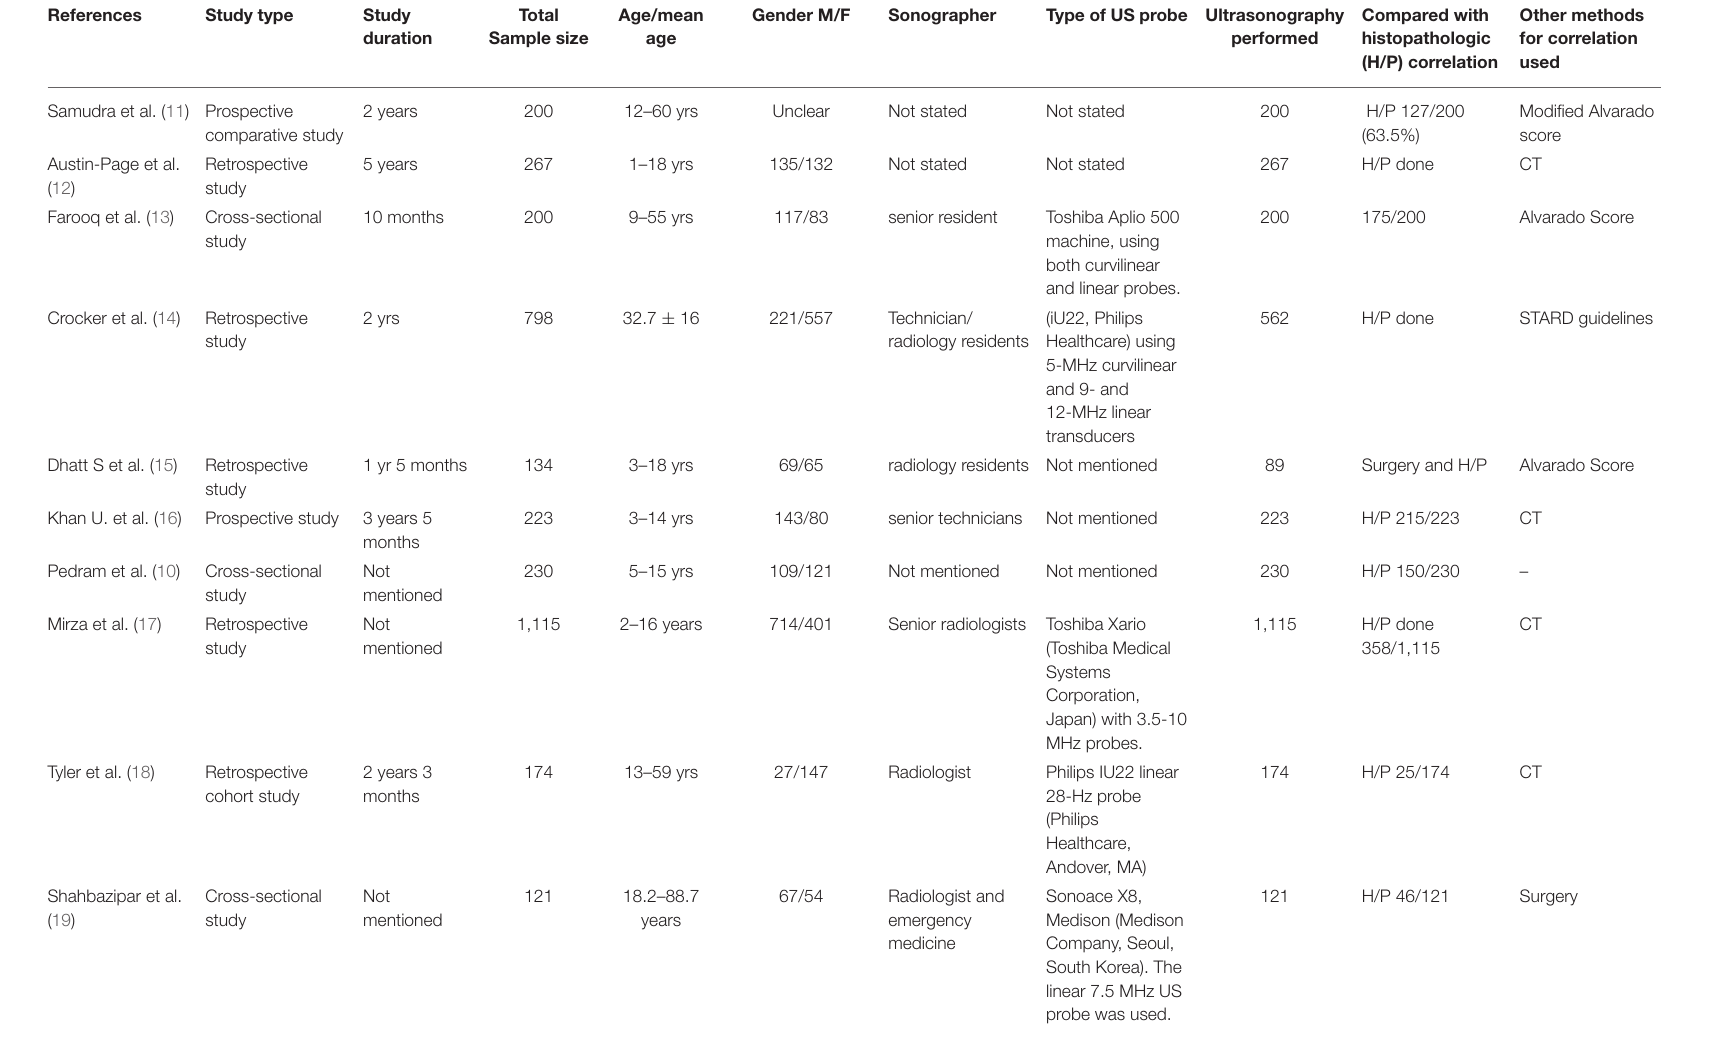
TABLE 1 | Demographic summary of included studies with ultrasound and histopathology in suspected cases of acute